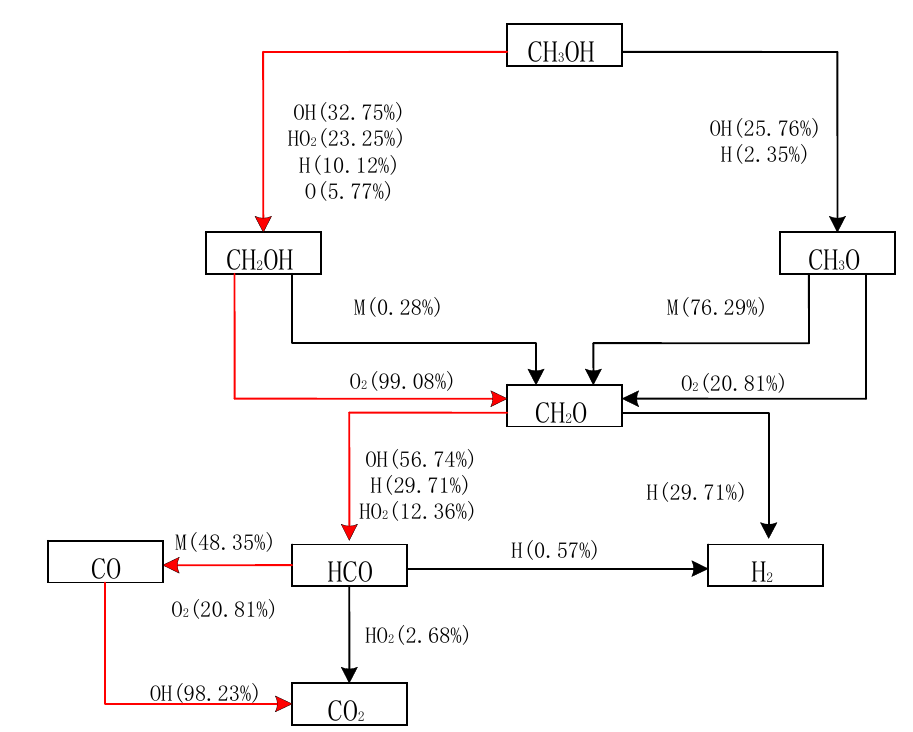
Figure 8. Reaction path diagram of